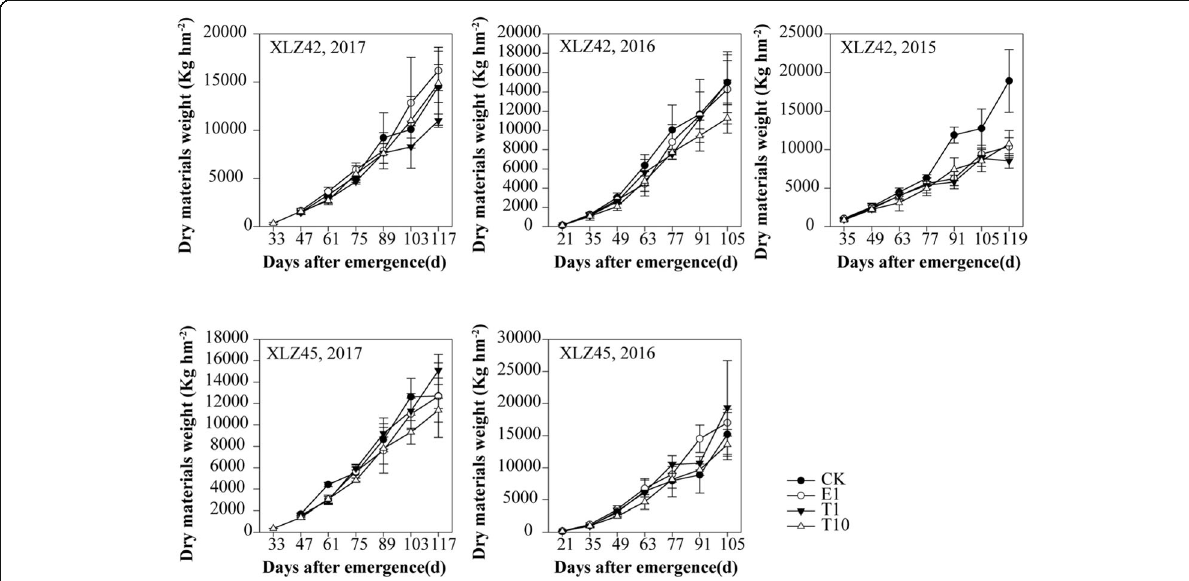
Fig. 11 Dry matter accumulation of two cotton varieties (XLZ42 and XLZ45) in various treatment groups: 1 and 10 days before the first irrigation (T1, T10, respectively) and 1 day before the second irrigation (E1) after seedling emergence, during 2015 – 2017. The control group (CK) had film mulching throughout the growth stages. Bars are means ± standard deviation (n = 3)